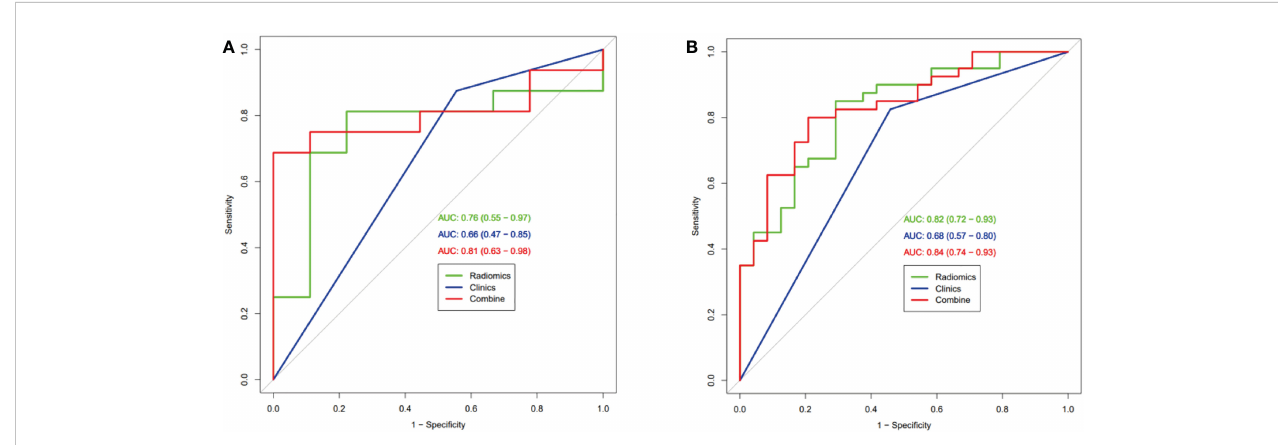
FIGURE 3 Receiver operating characteristic curve analysis of three models in the training set (A) and the validation set (B) for predicting Major Pathological